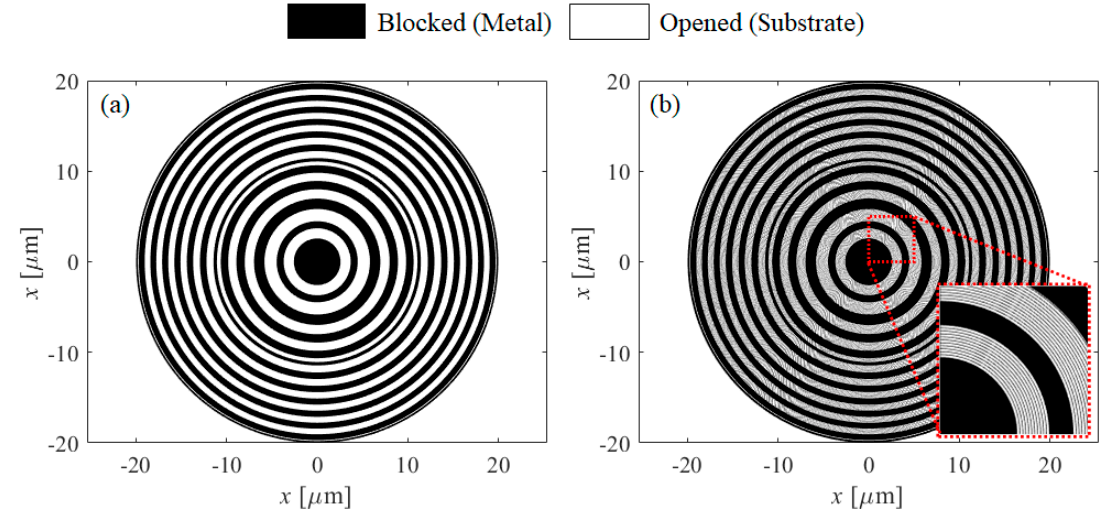
Figure 3. ( a ) The designed dual-focusing binary lens. ( b ) MSCRA assisted dual-focusing lens. The inset shows the magnified image.